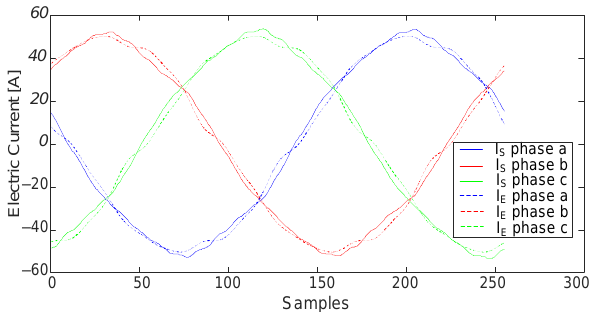
Figure 7. Comparison between I E and I S for synchronous generator.